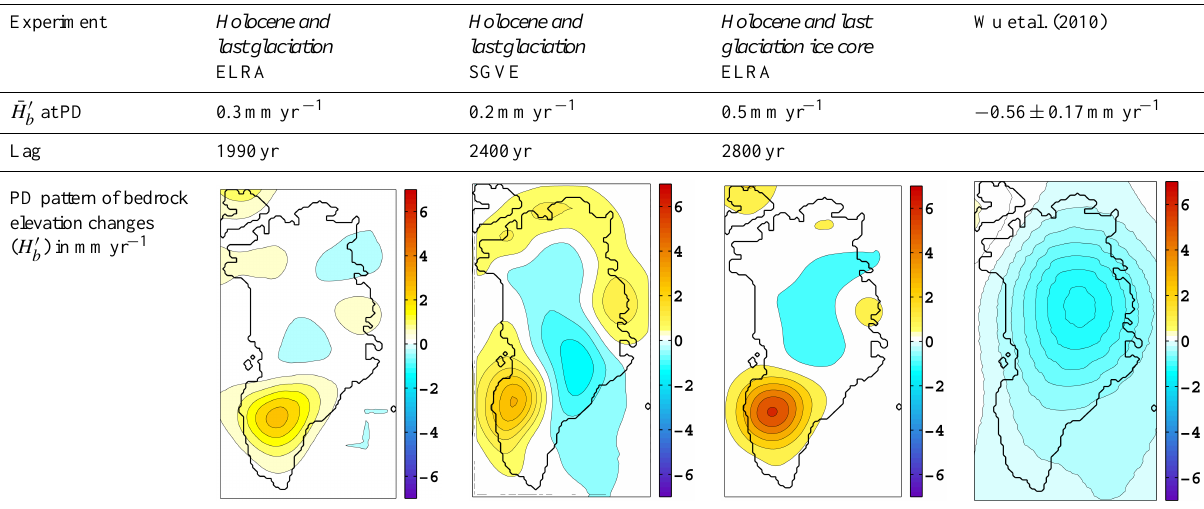
Table 2. Comparison of lag values, ¯ H 0 and the PD bedrock patterns obtained in this study and the geodic pattern reported by and Wu et al. b (2010). The values of bedrock changes corresponding to the experiments presented in this paper are uplift rates while the ones by W10 are geodic